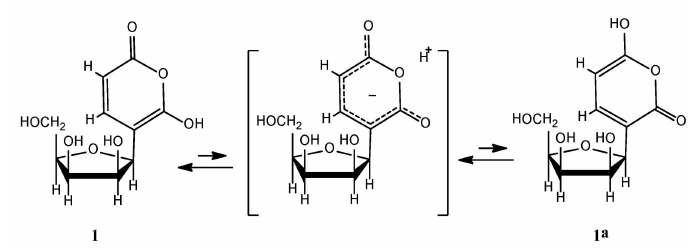
Figure 4. Tautomerization in Ochraceopyronide ( 1